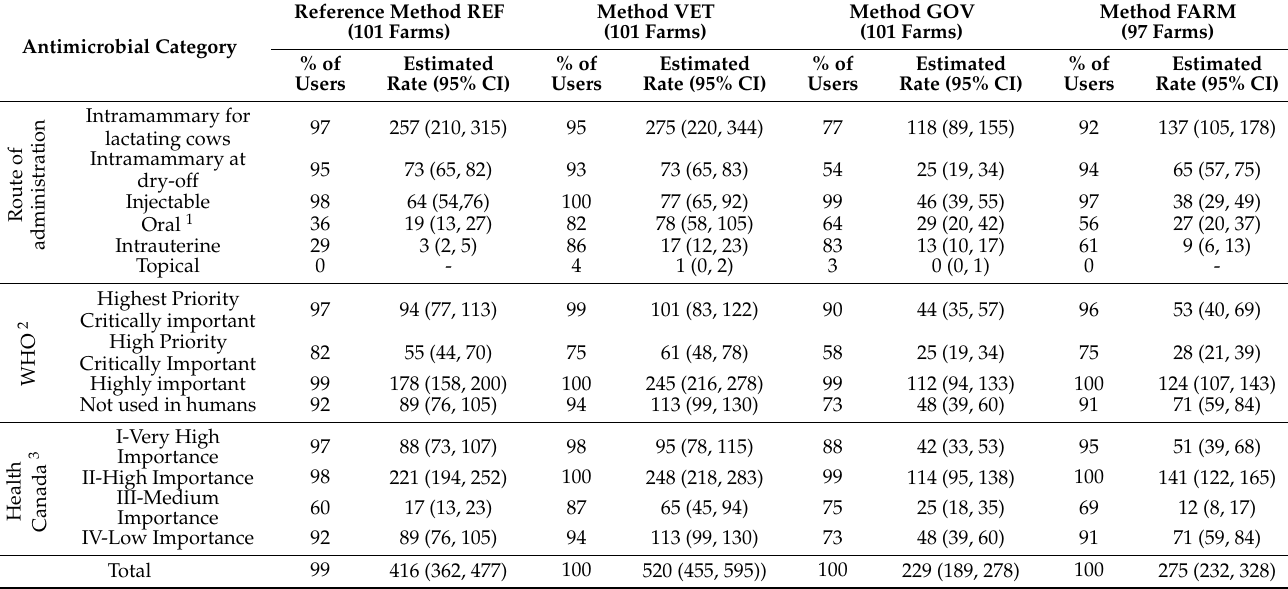
Table 1. Percentage of dairy producers using antimicrobial agents in products other than medicated feed, and estimates of the usage rate in Canadian Defined Course Doses for cattle (DCDbovCA)/100 cow-years (95% confidence interval, 95% CI) by route of administration, by category according to the World Health Organization (WHO) or to Health Canada, and in general, estimated using negative binomial regression models applied to four quantification methods in 101 or 97 dairy farms from Qu é bec, Canada: garbage can audit (REF method), all veterinary invoices (VET method), veterinary invoices eligible for the Qu é bec governmental program (GOV method), and farm treatment records (FARM method).